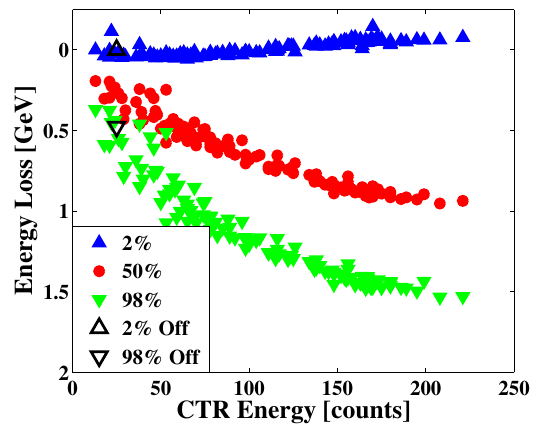
FIG. 6. (Color) ( Li (cid:1) (cid:1) (cid:3) ) Distribution of the 2%, 50%, and z 98% charge levels as a function of increasing CTR energy or decreasing bunch length. The 4 and 5 represent the 2% and 98% charge levels of the beam with no